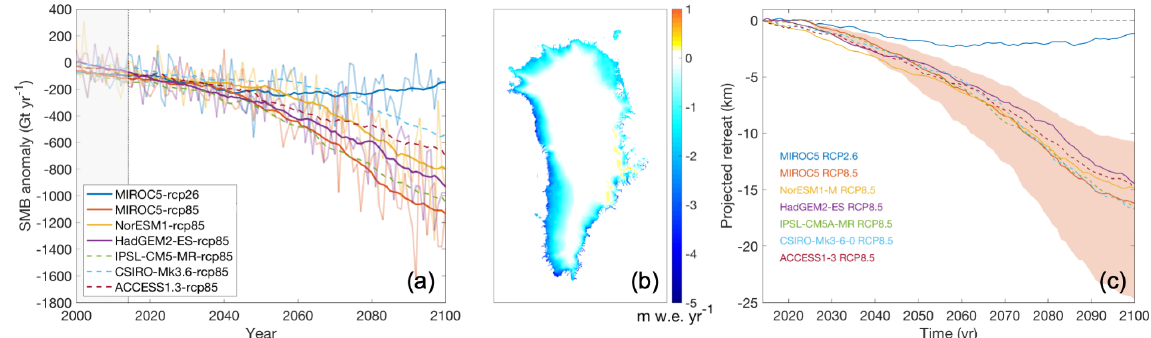
Figure 1. Illustration of atmospheric and oceanic forcing. (a) Greenland-wide SMB anomaly for projections starting at 2015. Strong lines are 10-year running mean values for the core experiments (solid) and extended CMIP5 experiments (dashed), plotted over the full time series in the background (omitted for the extended experiments for clarity). (b) spatial pattern of the average MIROC5-RCP8.5 SMB anomaly for the period 2091–2100. (c) Greenland-wide average of prescribed tidewater glacier retreat (Slater et al., 2019, 2020). The shading gives the range of ocean sensitivity sampled with two more experiments in MIROC5-RCP8.5-high and